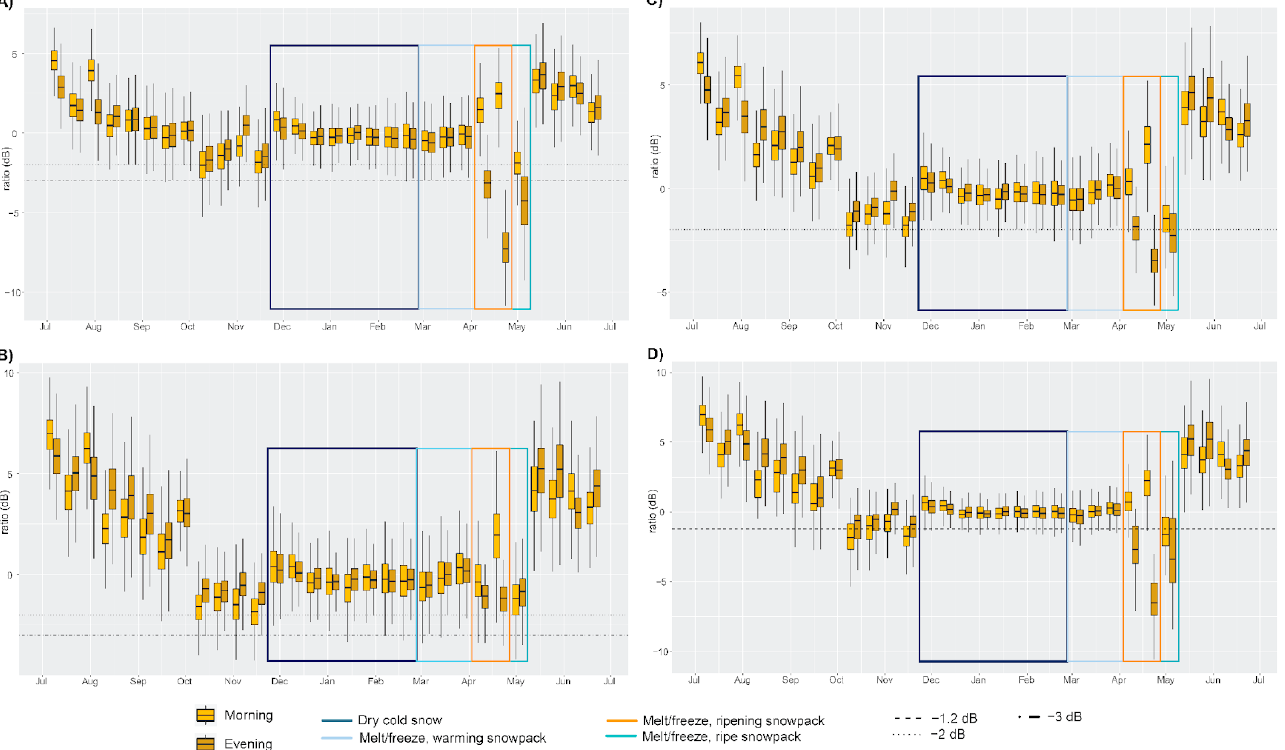
Figure A1. S1 ratio values over time for grassland cover focus area. ( A ) VV; ( B ) VH; ( C ) [33] co- /cross-polarized; and ( D ) [32] co-/cross-polarized ratio approaches. Morning and evening values are differentiated according to color shade. Dotted and dashed lines indicate threshold values of − 1.2 dB ([33]; dashed line), − 2 dB ([34]; dotted line), and − 3 dB ([21]; dotted-dashed line). Colored box outlines indicate field measurement-determined periods of a cold, dry winter snowpack (dark blue), surface melt/freeze cycles over a warming snowpack (light blue), surface melt/freeze cycles over a ripening snowpack (orange), and surface melt/freeze cycles over a ripe snowpack (cyan). Co-polarized ratio values (Figure A1A) remained stable from December through March; beginning in April, morning ratios increased and evening ratios decreased signif- icantly; a − 2 dB threshold dictates some outlying pixels as wet during the winter months,